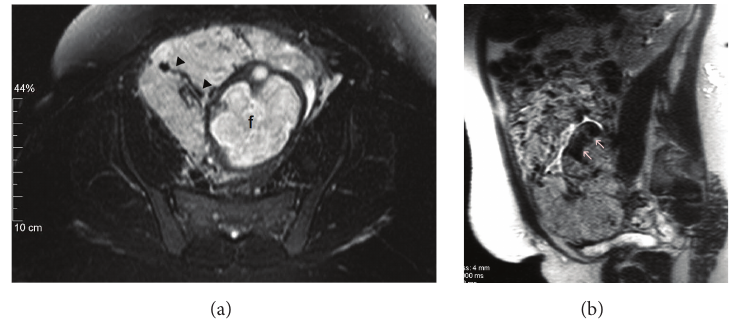
Figure 3: MRI of the pelvis without contrast performed 11 weeks later. (a) Transverse T2 fat suppressed image demonstrates enlarged intraplacental vessels (arrowheads) (f: fetal brain). (b) Sagittal T2 HASTE image shows thin uterine wall with dark intraplacental bands